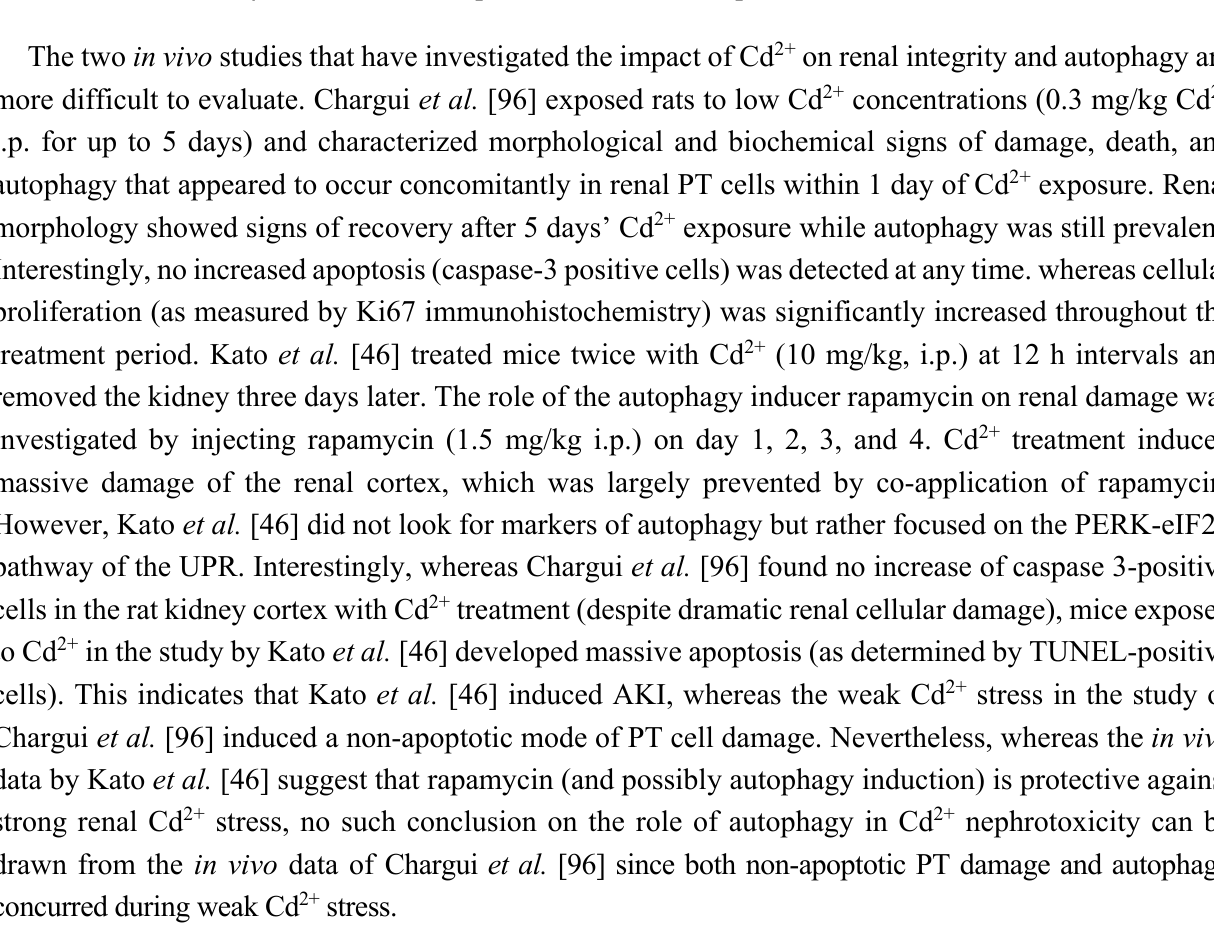
Figure 5. Effect of Cd 2+ and rapamycin on autophagy markers LC3-I/II and p62 in renal PT cells. ( A ) WKPT-0293 Cl.2 cells were exposed to 10 µM Cd 2+ for 1 h or to 100 nM rapamycin for 24 h and LC3 immunoblots were performed; ( B ) NRK-52E cells were cultured in medium containing 1% or 10% FBS, exposed to different concentrations of rapamycin for 24 h, and autophagy markers LC3 and p62 were determined by immunoblotting. Loading was monitored with β -actin. Data are representative of 2–4